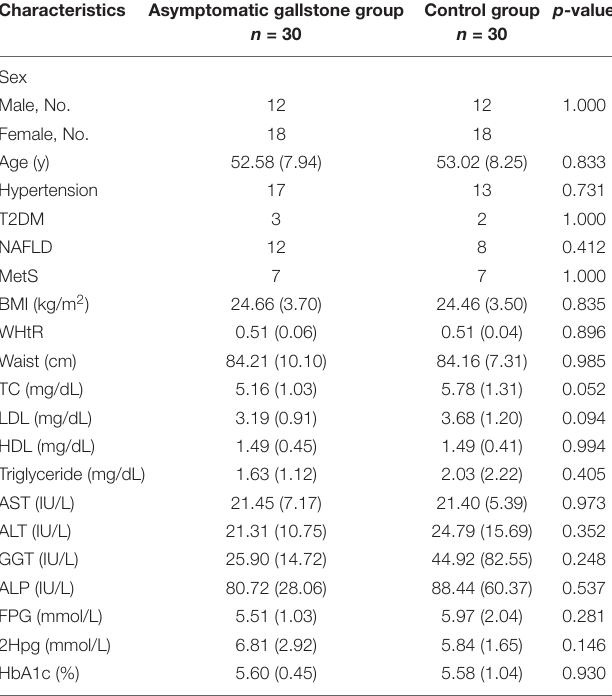
TABLE 1 | Clinical characteristics of the subjects. Characteristics Asymptomatic gallstone group